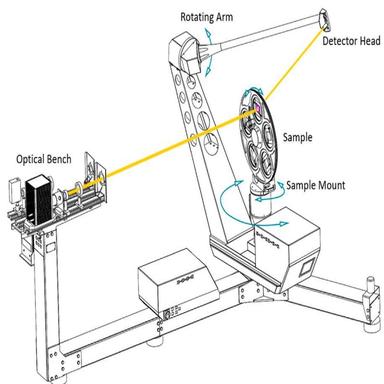
Isometric view of the pgII goniophotometer, the arrows indicate the axes of the detector and sample. Distance from sample to the detector is 1 m .